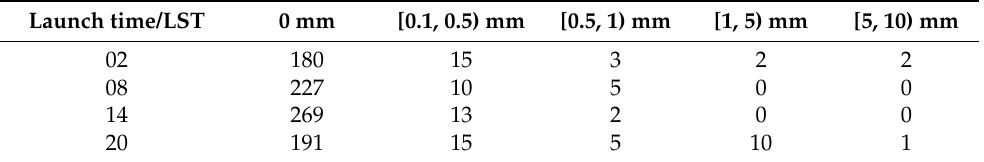
Table 1. The sample numbers of hourly precipitation in different grades at launch times in Jiulong during 2013–2020 after removing observations with precipitation in the previous